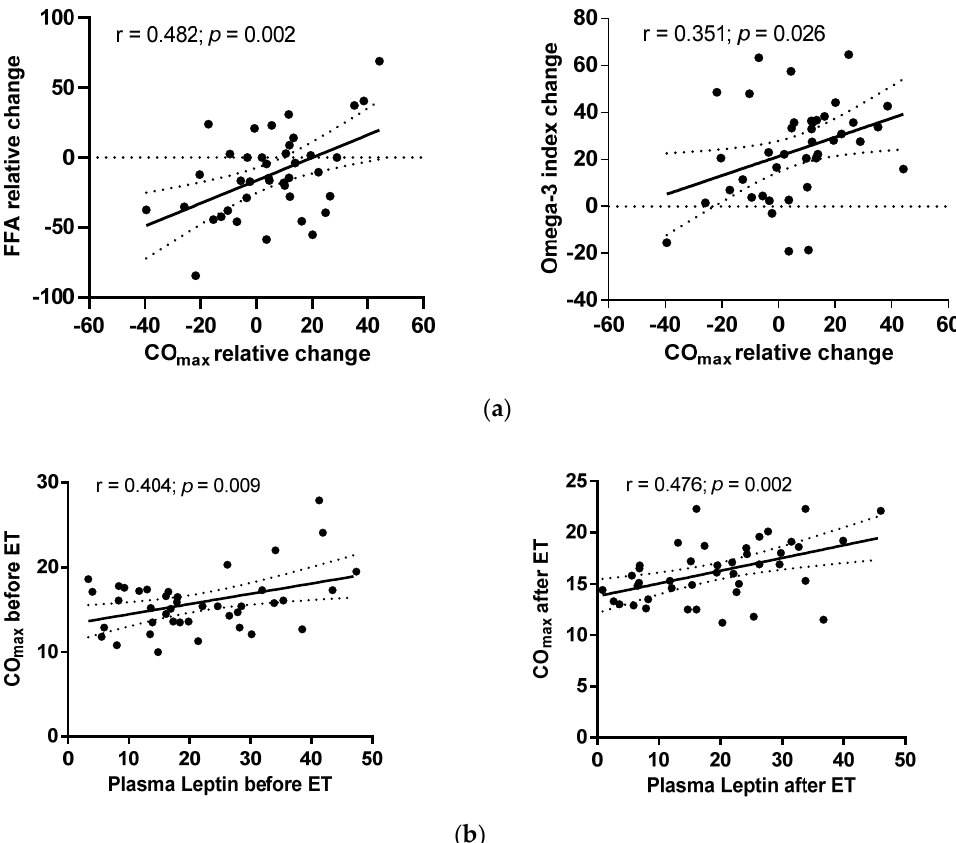
vascular resistance.